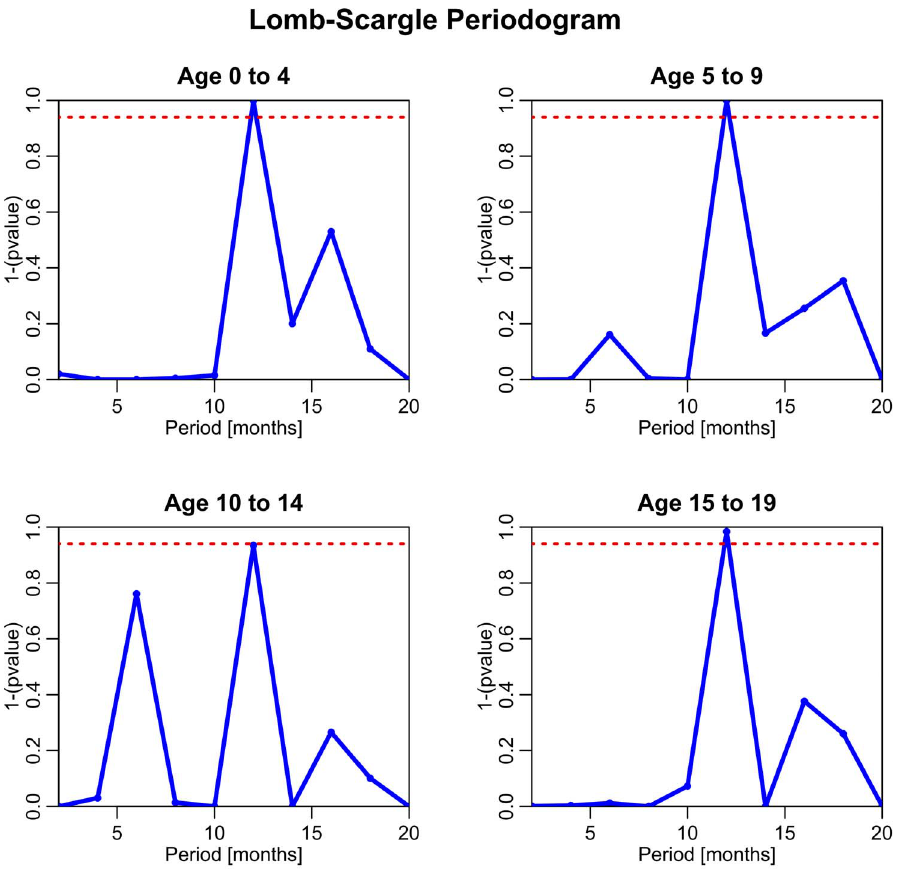
Figure 2. Lomb-Scargle periodograms testing the significance of cyclical patterns of periods between 2 and 20 months in the time series of incidence monthly SSTIs. Points above the red dotted line indicate the period is significant to p ,